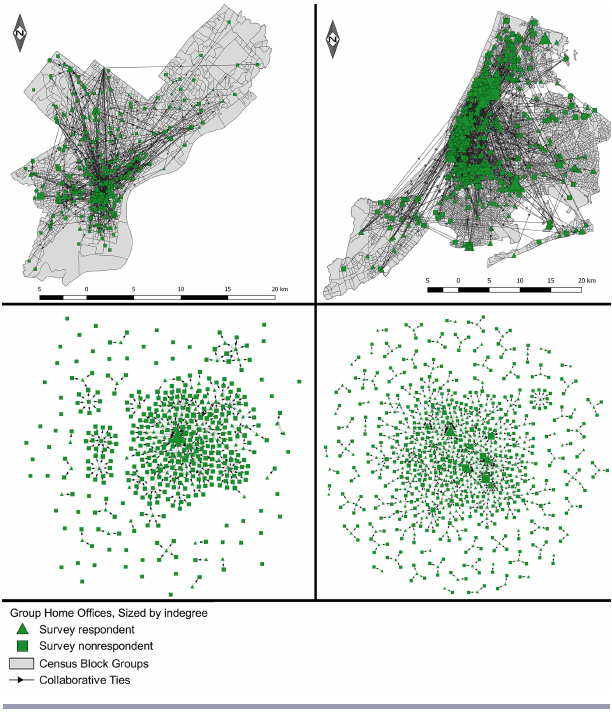
Fig. 2 . Networks for Philadelphia (left) and New York